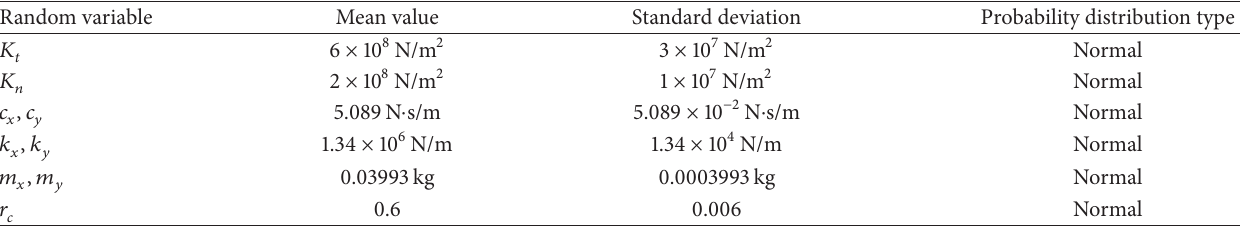
Table 1: Dynamic parameters of the simulated milling system and mean values and standard deviations of the corresponding probability